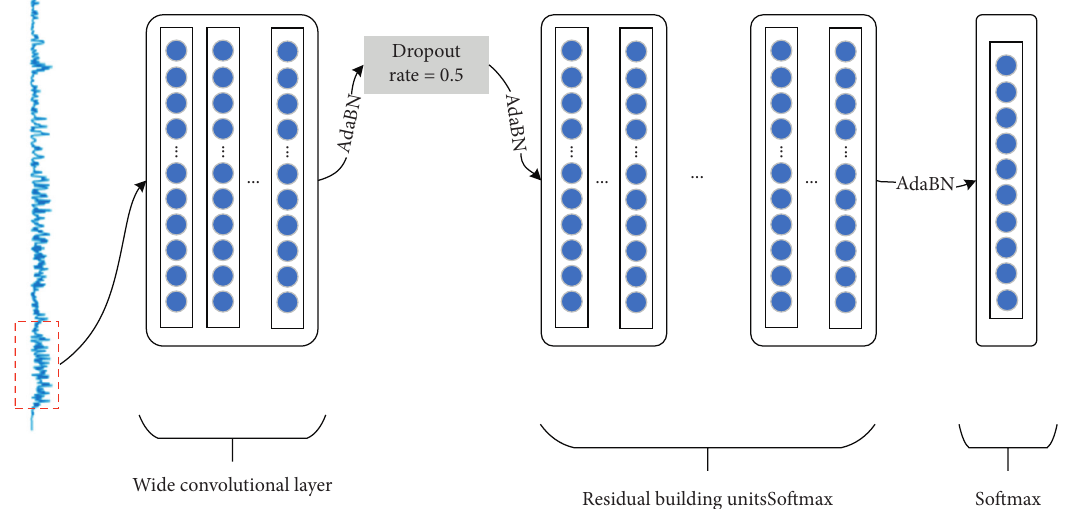
Figure 2: Framework of the fault diagnosis model based on